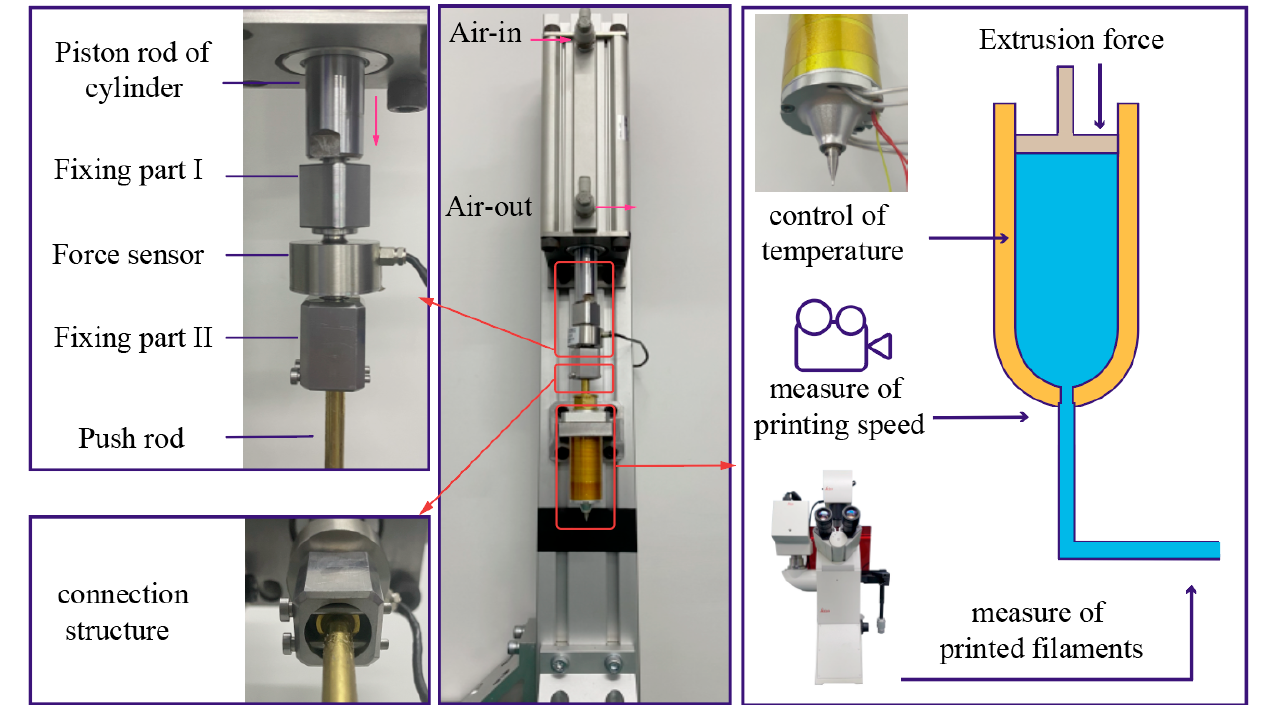
Figure 3. Process of the extrusion experiment.